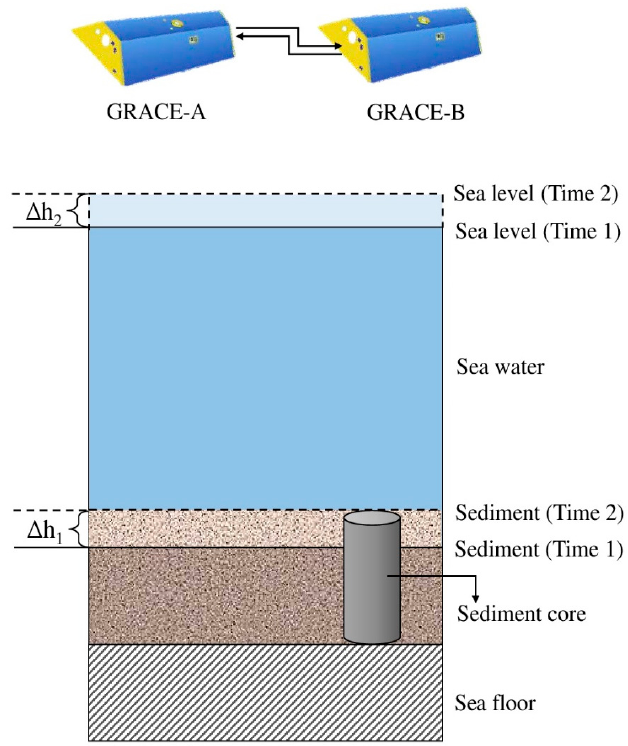
Figure 3. GRACE-derived mass changes over the ECS in connection with sediment deposition, sea level change and depletion of seawater. A sample sediment core is drilled to analyse the cumulative mass of the